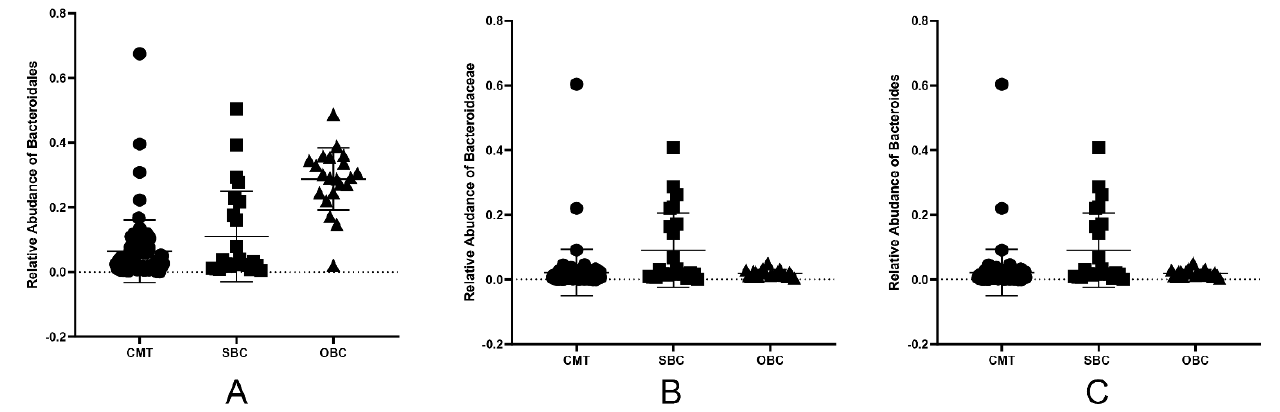
Figure 5. The relative abundance of common microbiota in tumors, gut and oral samples of dogs with CMTs. The Bacteroidales , Bacteroidaceae and Bacteroides were detected in canine mammary tumors, and were found in both disordered oral and gut microbiota. ( A ) The relative abundance of Bacteroidales in tumors (CMT group), gut (SBC group) and oral (OBC group) samples of dogs with CMTs; ( B , C ) The relative abundance of Bacteroidaceae ( B ) and Bacteroides ( C ) in CMT, SBC and OBC groups. Black circles, black squares and black triangle represent tumor, feces and oral swabs samples, respectively.